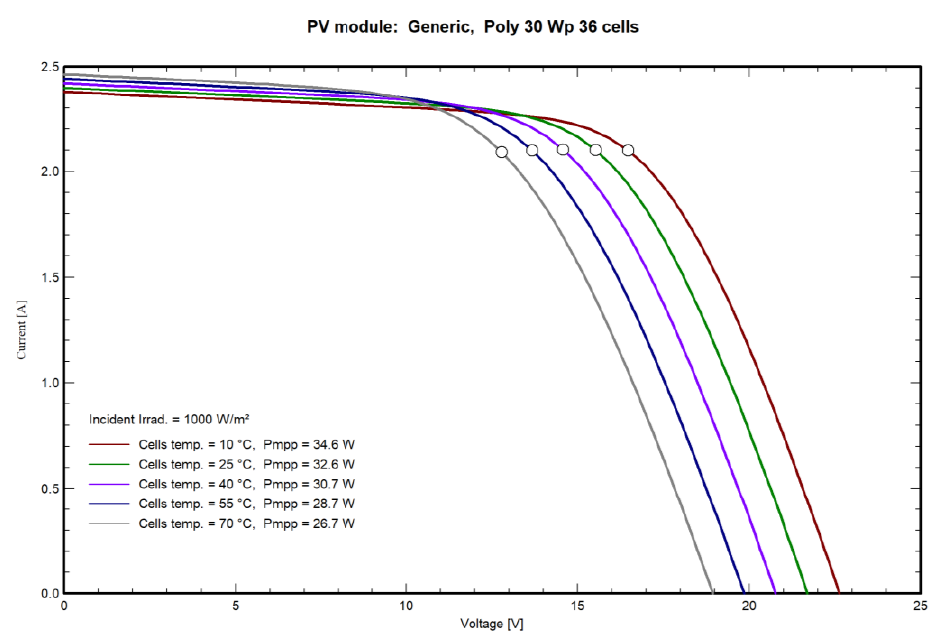
Figure 1. Effect of temperature on I-V characteristics of PV.